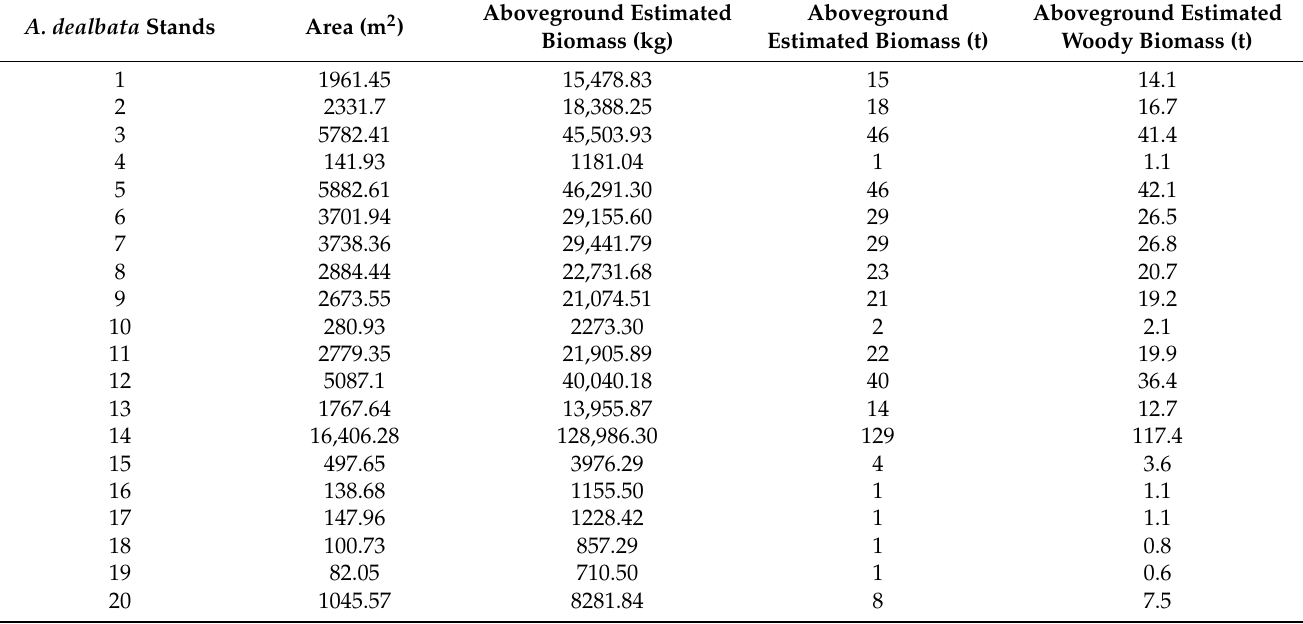
Table 5. Area of settlements of A. dealbata existing in the territory of the União de Freguesias de Cabeça e Vide.